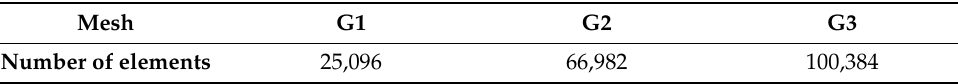
Figure 3. ( A ) Comparison of numerical results with [59]; ( B ) Grid independent study [60]. Table 2. Numerical test results for grid independence study.